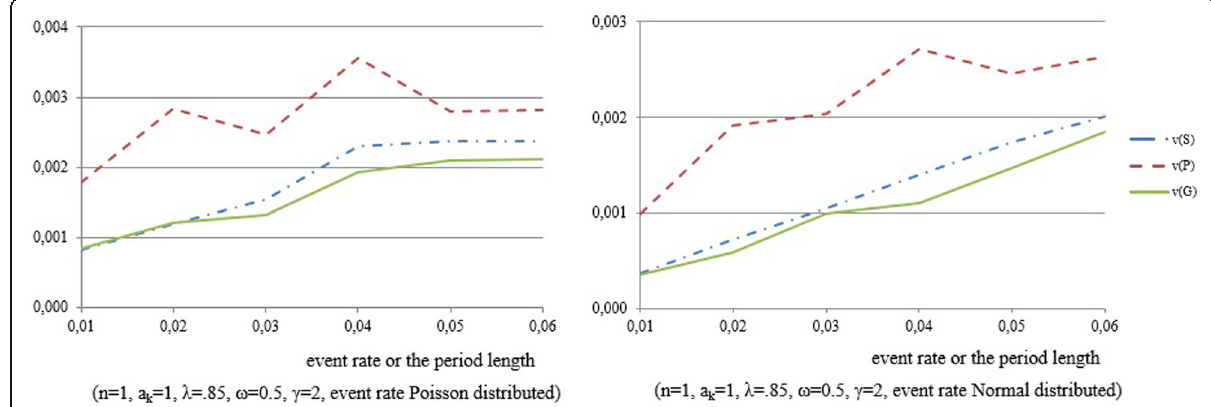
Fig. 7 Upper bounds of security v(A S ), privacy v(A P ) and service v(A G ) risk for various event rates, which also means various period length